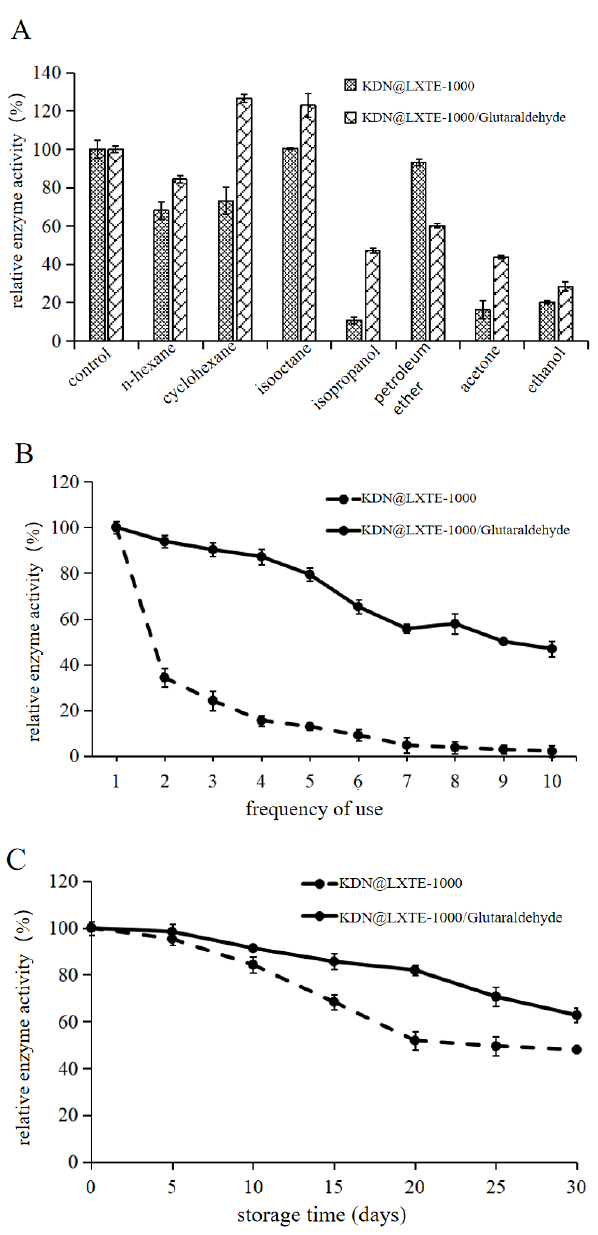
Figure 5. Solvent tolerance, reusability, and storage time analysis. ( A ) Solvent tolerance, the 100% of residual activity for KDN@LXTE-1000/Glutaraldehyde, and KDN@LXTE-1000 indicated as the initial lipase activity without solvent addition. ( B ) Reusability. ( C ) Storage time.